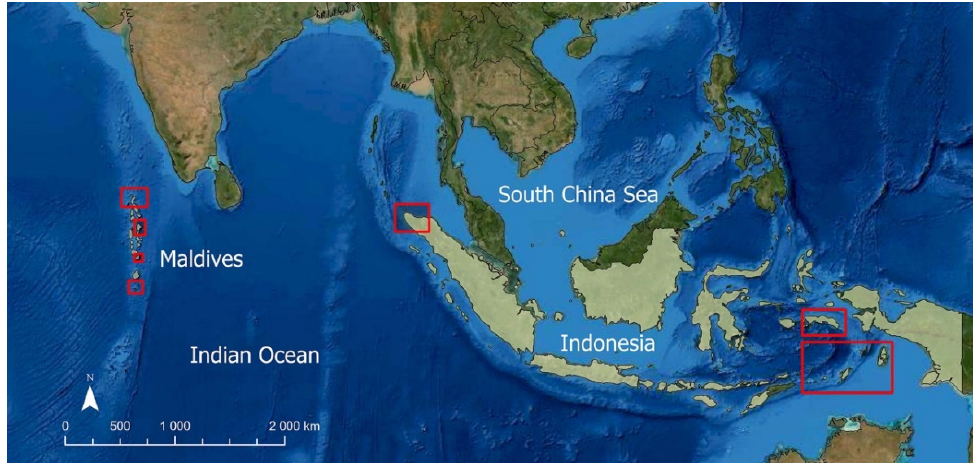
Figure 1. Map showing the areas of operation for the Maritime Asia Heritage Survey. The red boxes show areas of the Maldives and Indonesia covered by our survey and documentation as of May 2022.